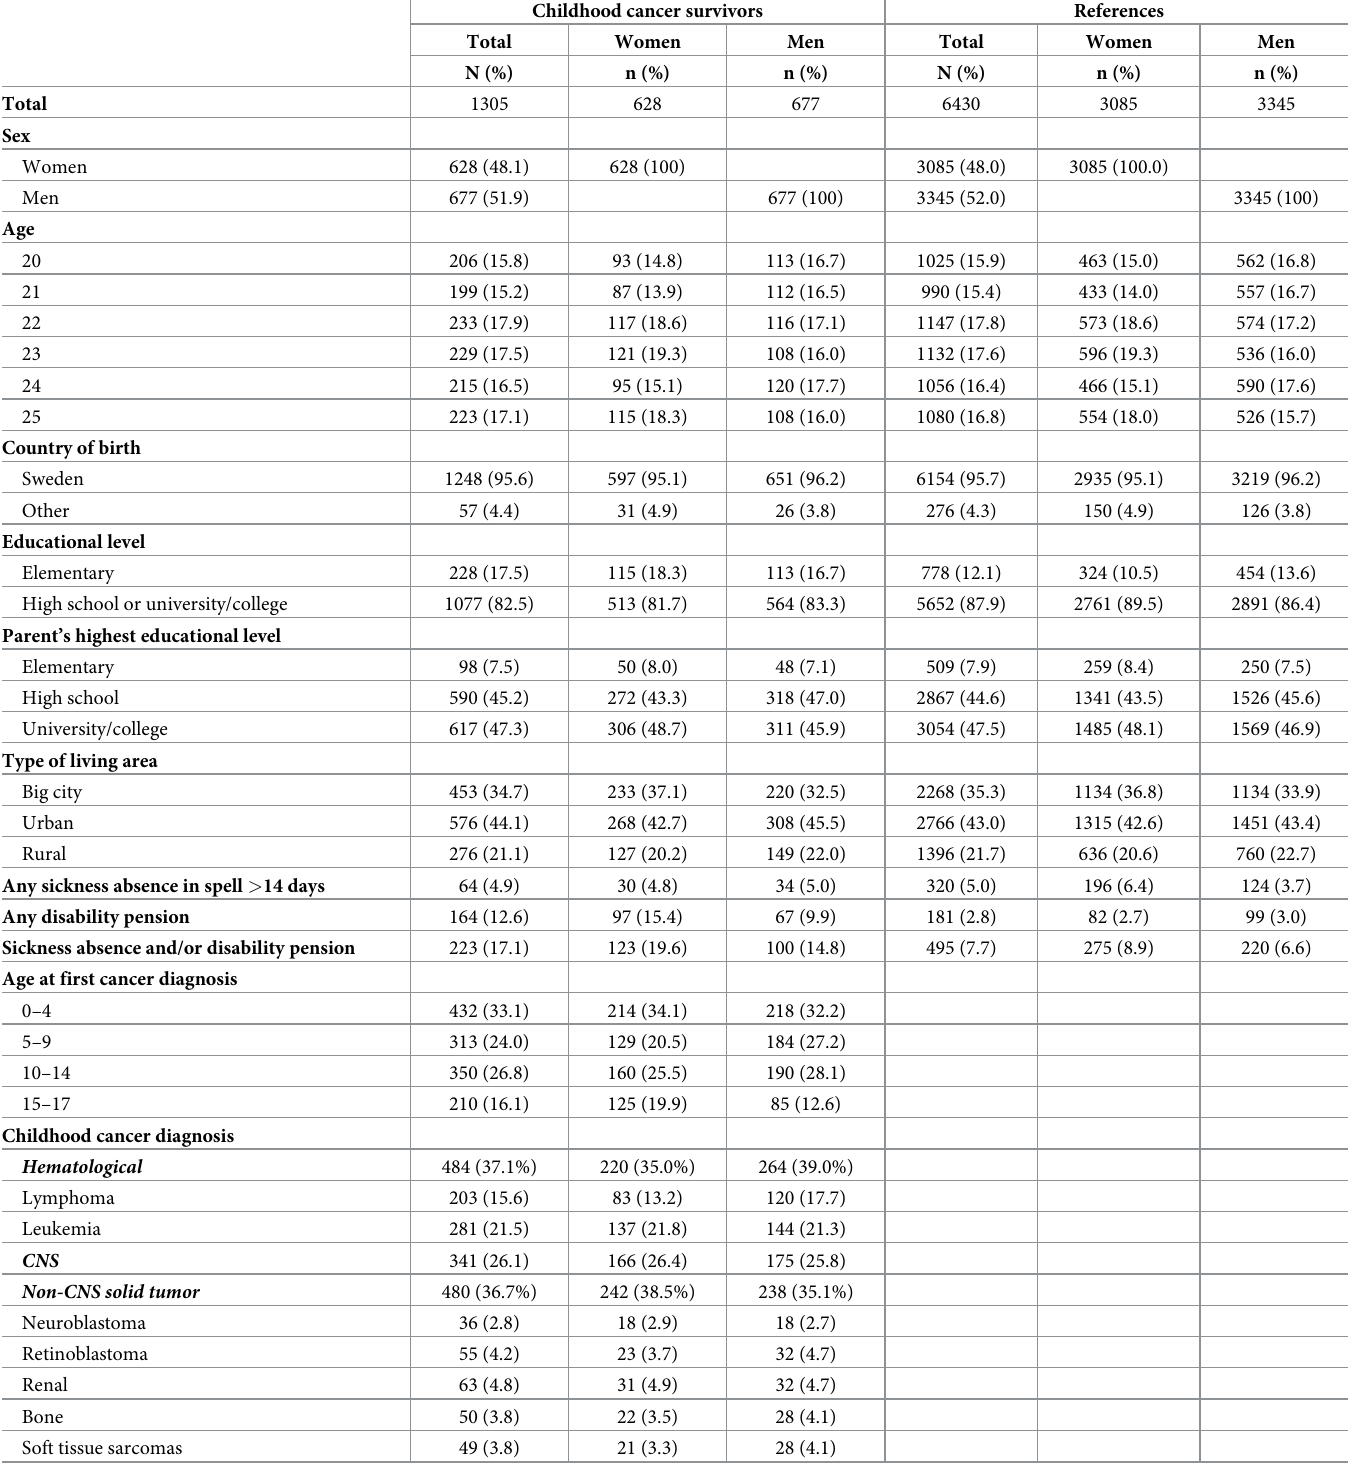
Table 1. Distribution of sociodemographic characteristics at baseline (2008) among childhood cancer survivors and matched references, and childhood cancer char- acteristics among childhood cancer survivors; among all and stratified by